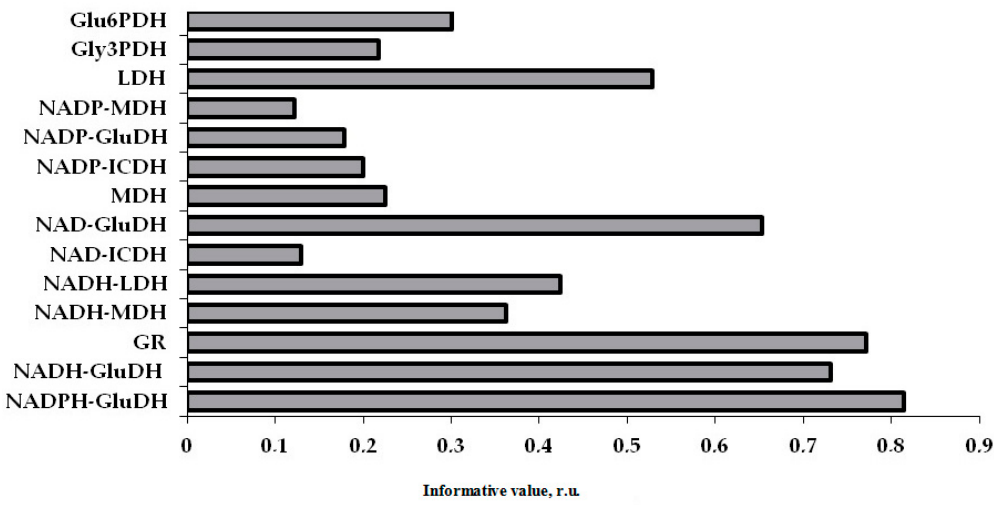
Figure 5. Information content of NAD and NADP-dependent platelet dehydrogenases in the neural network classification in ACS patients with ADD in the prognosis of the development of cardiovascular complications. Notes: r.u.—relative